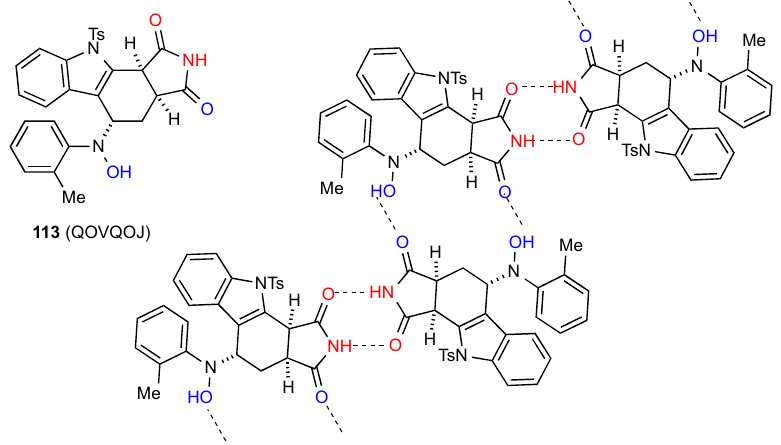
Figure 38. Structure adopted by compound 113.